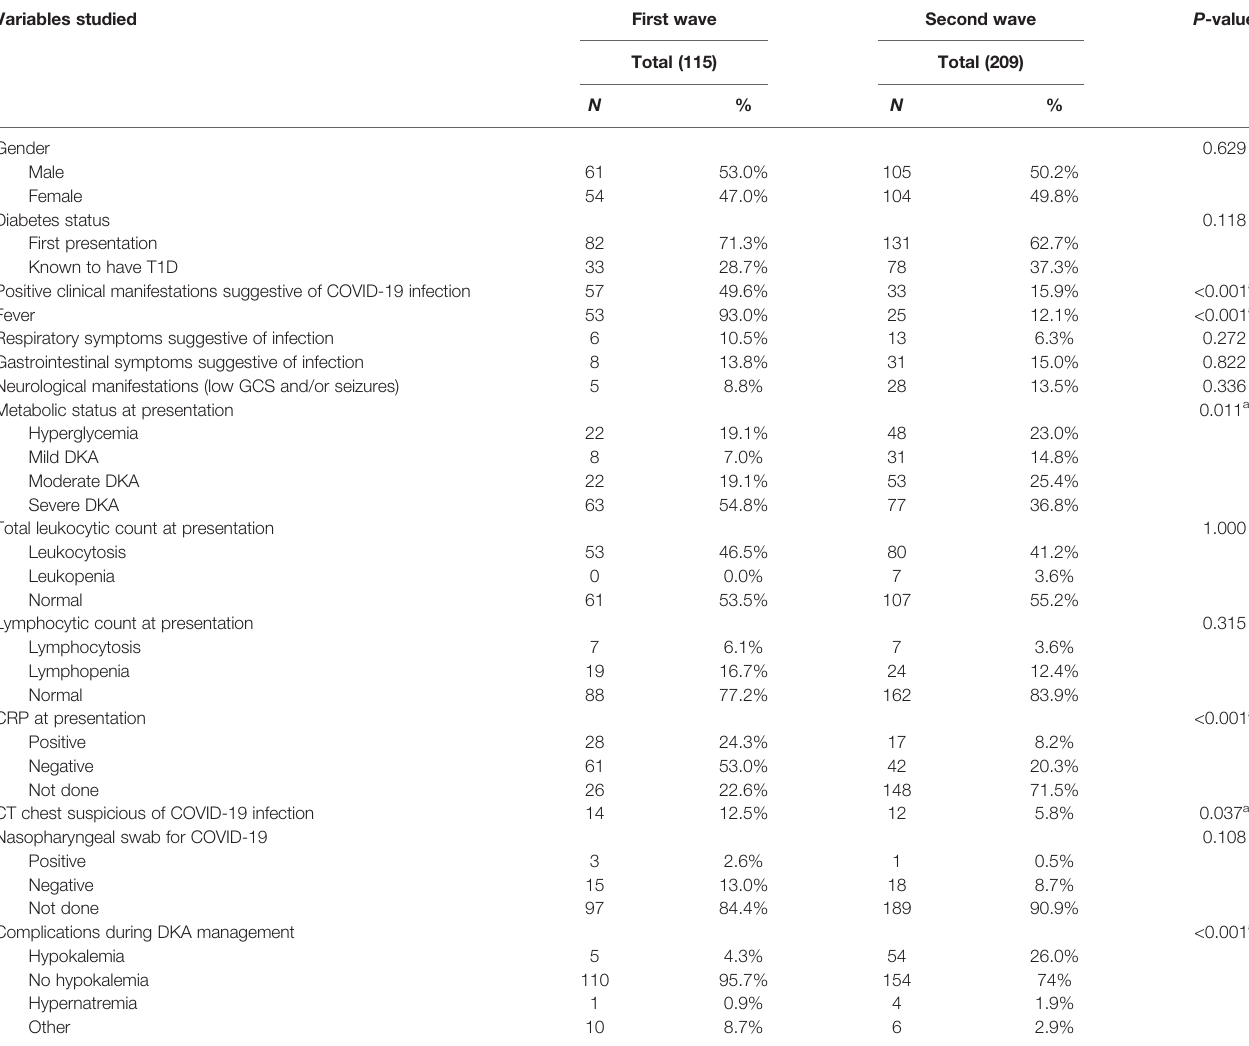
TABLE 1 | Comparison between the fi rst and the second COVID-19 waves regarding the patients ’ demographic, clinical, laboratory, and radiological data. Variables studied First